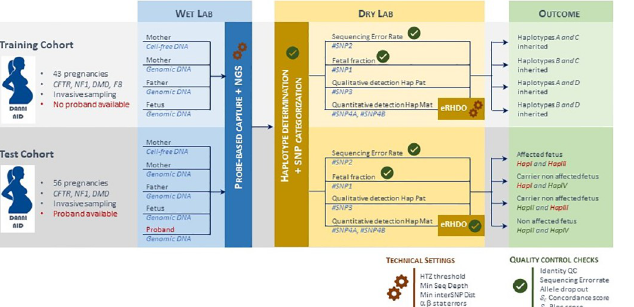
Fig 1. Workflow and processing steps for samples obtained from the training and test cohorts. The training cohort included couples at risk for SGD who were offered invasive prenatal testing and for whom parental haplotypes were determined using fetal genomic DNA from the current pregnancy. Test cohort included pregnant women at risk for SGD who were offered invasive prenatal testing and for whom a proband’s genomic DNA was available for haplotype reconstruction. The training cohort study allowed to evaluate and optimize the technical settings. The best combination of settings was then used to explore the test cohort. Finally, the diagnostic performance of our SGD-NIPD workflow with eRHDO was evaluated and compared to gold standard as defined by fetal status obtained by invasive sampling. Quality controls measures are described to minimize errors and to aid in technical validation and biological interpretation of the result.